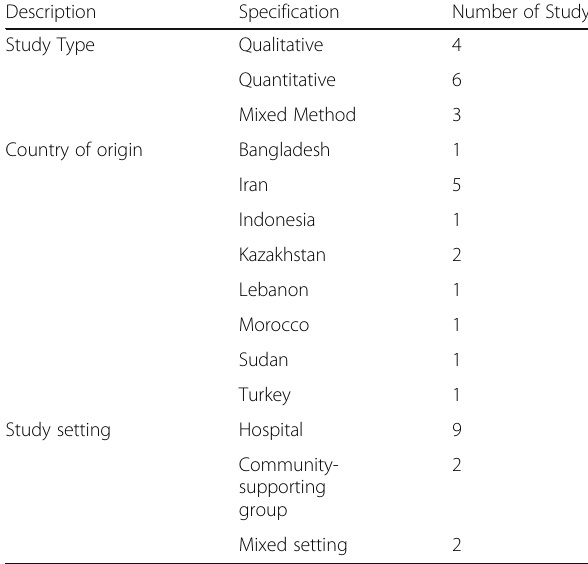
Table 3 General characteristics of the included publications Description